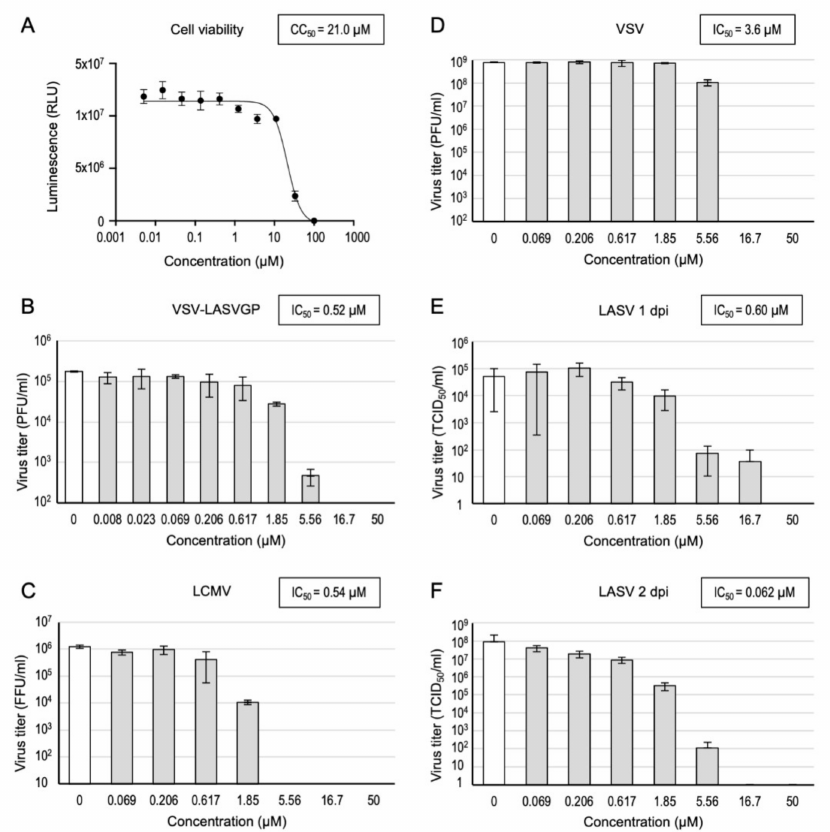
Figure 2. Antiviral effects of CP100356 on pseudotyped vesicular stomatitis virus harboring LASV glycoprotein (VSV-LASVGP), lymphocytic choriomeningitis virus (LCMV), and authentic LASV. ( A ) Cell viability of Vero cells was measured by performing a CellTiter-Glo assay after 24 h of treatment with CP100356 at the indicated concentrations. ( B ) Vero cells treated with the indicated concentrations of CP100356 were infected with VSV-LASVGP at a multiplicity of infection (MOI) of 0.01, and virus titers were determined by performing the plaque assay at 24 h post-infection (hpi). ( C ) Vero cells treated with the indicated concentrations of CP100356 were infected with LCMV at an MOI of 0.01, and virus titers were determined at 48 hpi by counting focus-forming units using an anti-NP antibody. ( D ) Vero cells treated with the indicated concentrations of CP100356 were infected with VSV at an MOI of 0.01, and virus titers were determined by plaque assay at 24 hpi. ( E , F ) Vero cells treated with the indicated concentrations of CP100356 were infected with LASV at an MOI of 0.01, and virus titers were determined at 1 day post-infection (dpi) ( E ) and 2 dpi ( F ) by median tissue culture infectious dose assay. The values indicate means ± standard deviation of the experiment in biological triplicates for each concentration of